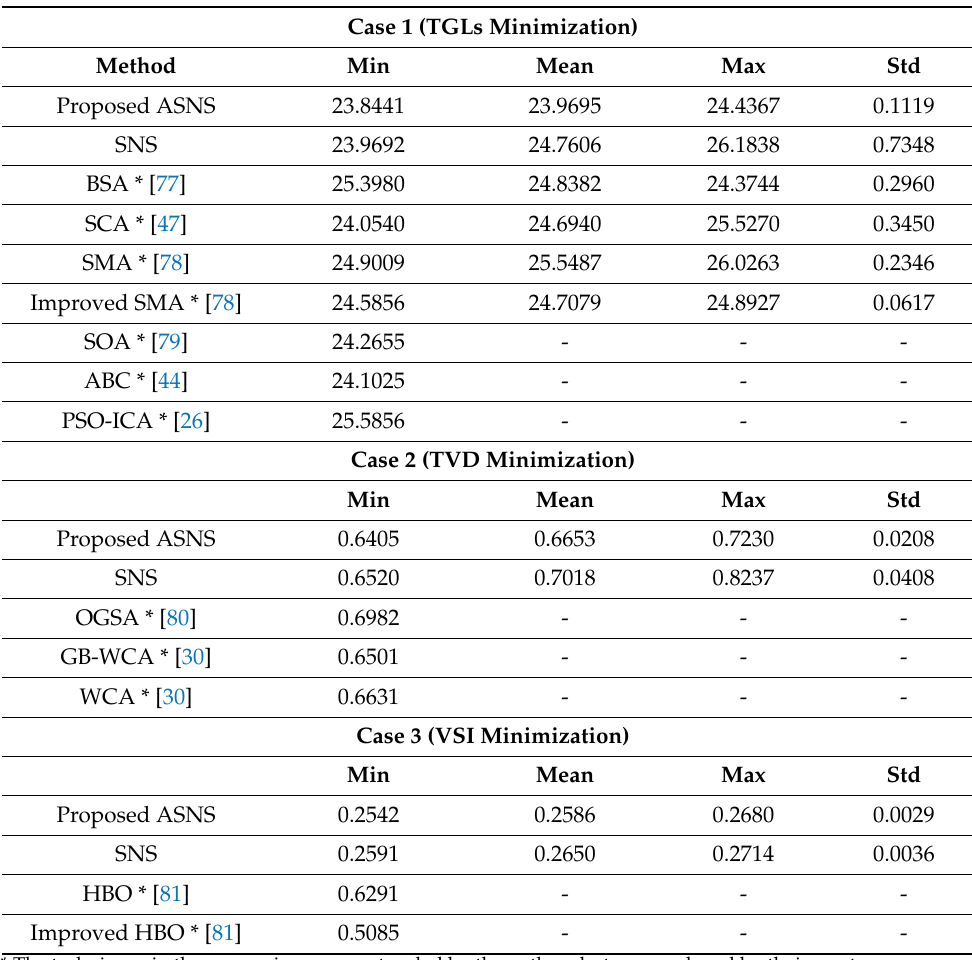
Table 8. Comparative results for Cases 1 and 2 of the IEEE 57-bus